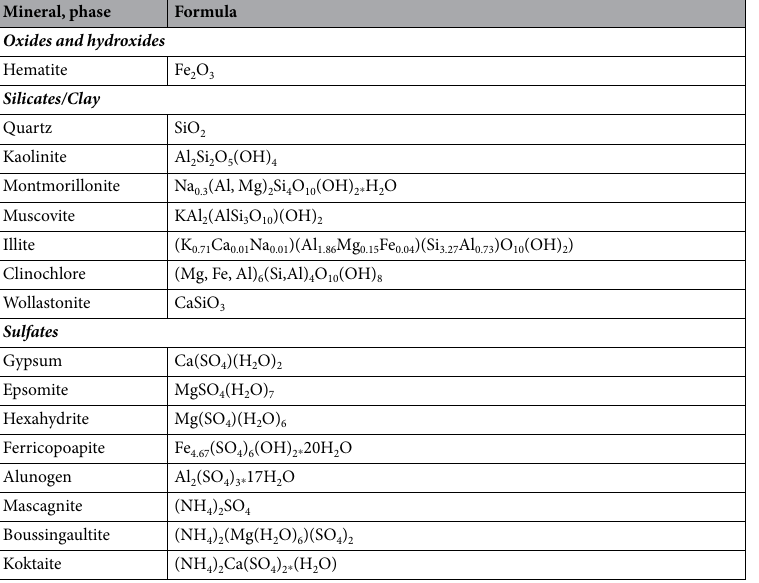
Table 1. Minerals identified by XRD in samples AL3T, AL3B, and AL3crust.